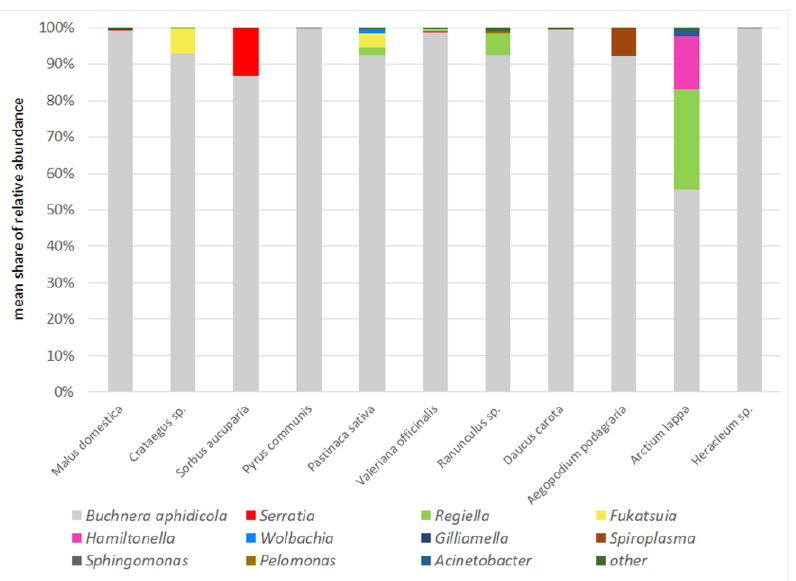
Figure 8. Mean shares of particular endosymbionts in reference to host plants ( Malus , Crataegus , Sorbus, and Pyrus are primary hosts, the remaining plants species are secondary hosts).